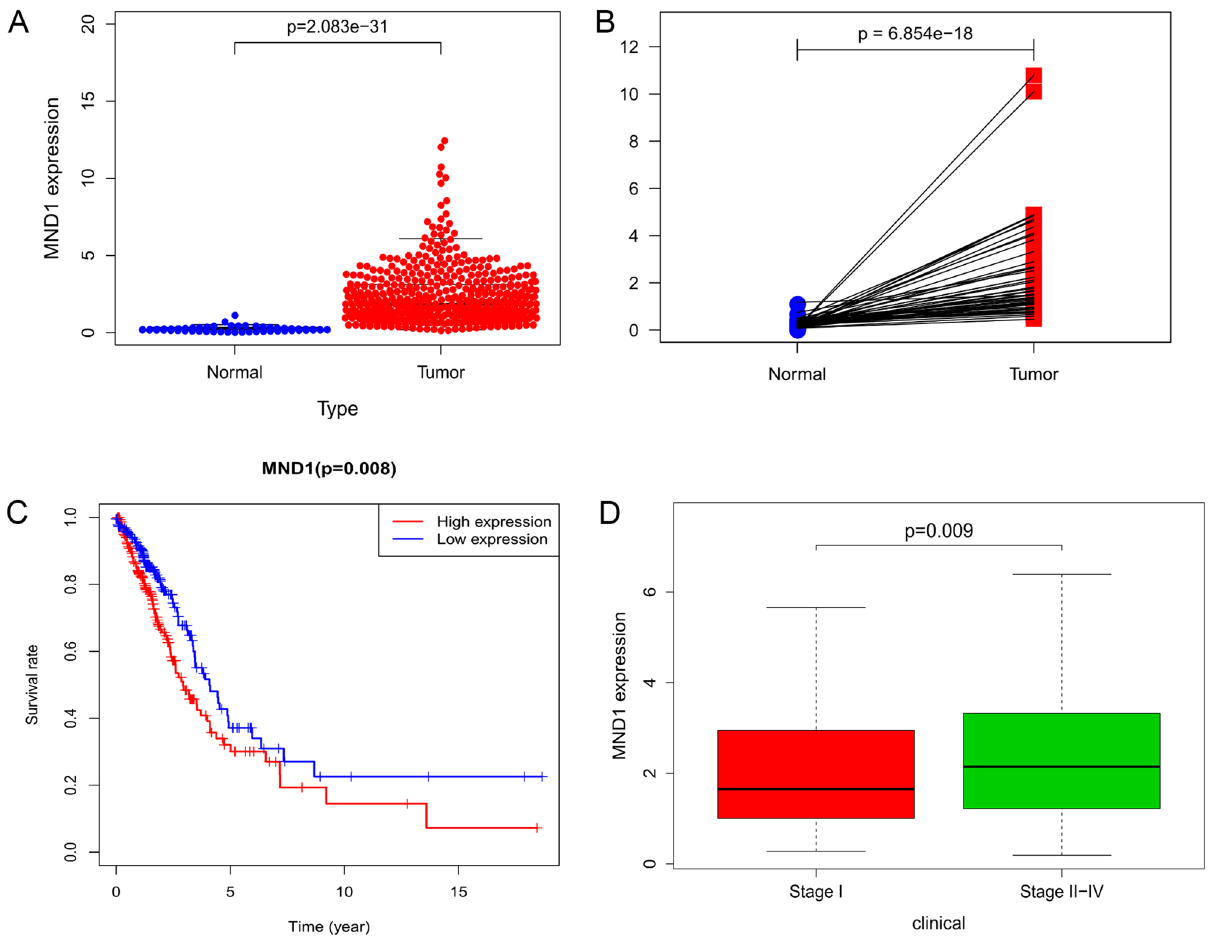
Figure 2. Associations of MND1 expression with clinic-pathological characteristics. ( A ) MND1 expression in healthy and LUAD tissues. ( B ) Different expression of MND1 in normal–LUAD paired tissues. ( C ) Survival rates with elevated and low expression of MND1. ( D ) Differential expression of MND1 between stage I and stage II–IV LUAD cases.